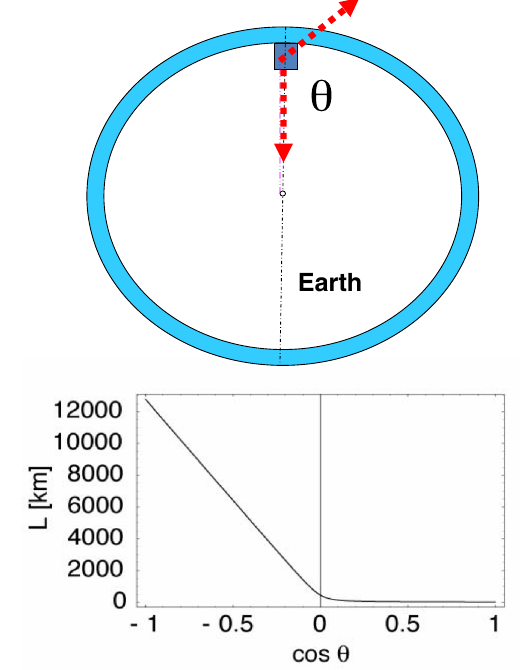
Fig. 6 Zenith angle and path length of neutrinos before interaction in the detector